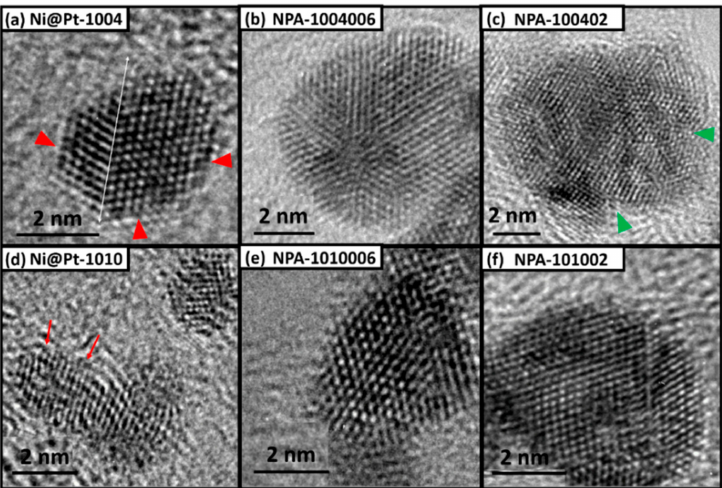
Figure 1. HRTEM images of experimental nanocatalysts (NCs). ( a ) Ni@Pt-1004 NC with Pt / Ni ratios of 0.4 ( b ) and 2.0 wt.% Au-cluster-decorated NI@Pt-1004 NCs (NPA-1004006), ( c ) 9.0 wt.% Au-cluster-decorated NI@Pt-1004 NCs (NPA-100402), ( d ) Ni@Pt-1010 NCs with Pt / Ni ratios of 1.0 ( e ) and 2.0 wt.% Au cluster-decorated NI@Pt-1010 NCs (NPA-1010006), and ( f ) 9.0 wt.% Au